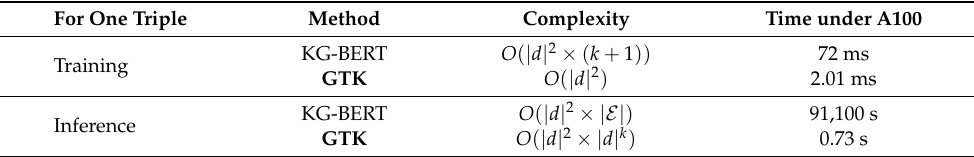
Table 4. Training and inference speed comparison. | d | refers to the length of the entity description. k refers to the number of negative samples of KG-BERT and the beam size for the proposed model. |E| refers to the number of unique entities in the knowledge graph. We used time under A100 to estimate the training and inference speed on